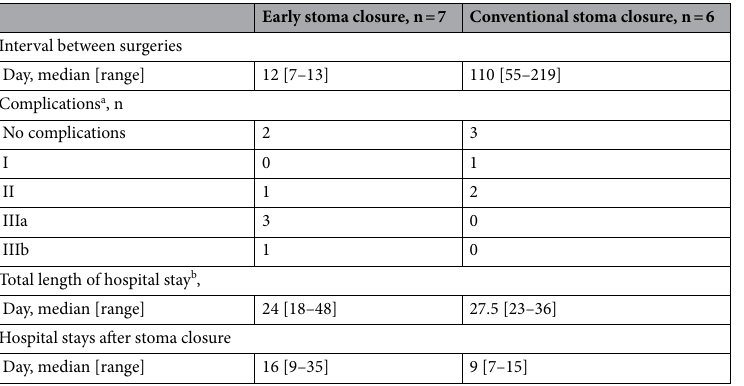
Table 3. Clinical course after early and conventional stoma closure. a Complications are grouped according to the Clavien–Dindo classification. b For patients undergoing conventional stoma closure, sum of the hospital stays at first and second admission was